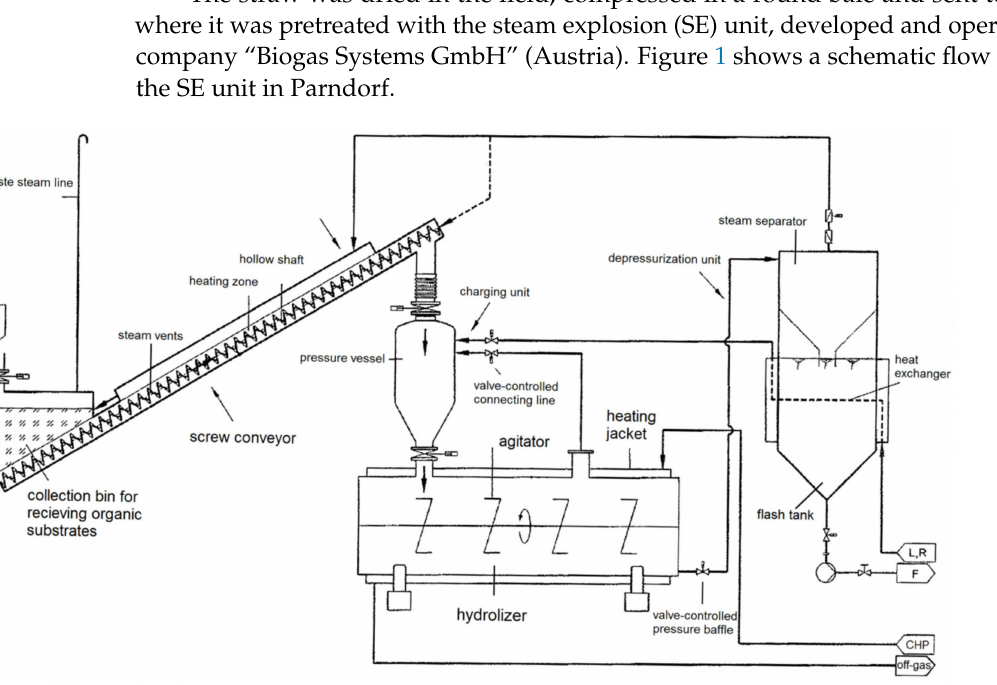
Figure 1. Schematic diagram of SE unit in Parndorf, Austria